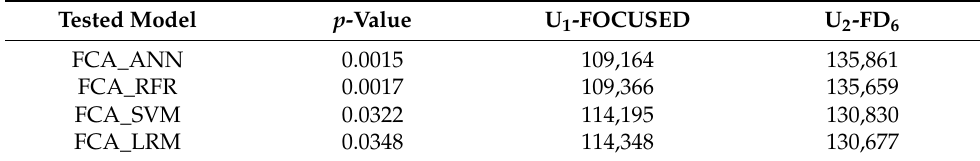
Table 2. Results of Mann-Whitney U Test.